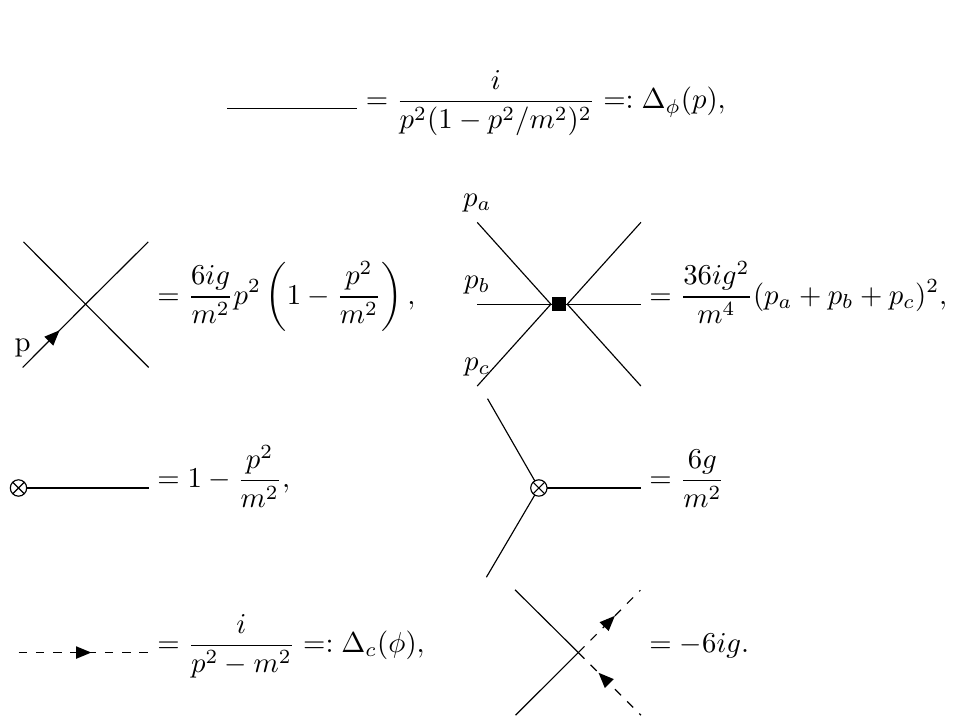
Figure 1 . Feynman rules from eqs. (A.2), (A.3), (A.4). Crossed dots represent sources. Solid and dotted lines correspond to (cid:30) and ghosts, respectively. An arrow over a (cid:30) line is used to specify